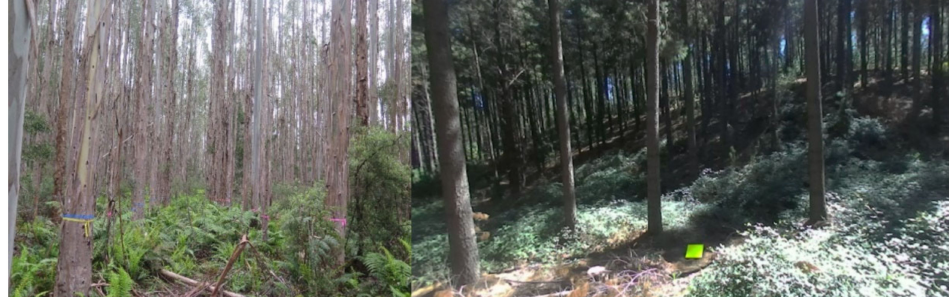
Figure 1. Understory vegetation and coarse woody debris are common in Australian plantation forests. The left image is representative of eucalyptus nitens’ plantations in Tasmania, Australia. The tape is positioned at 1.3 m above the ground, indicating that much of the understory was up to this height. It is also common for blackberry infestations to be present in areas, making access particularly di ffi cult, such as in the right image captured in a radiata pine plantation in New South Wales,